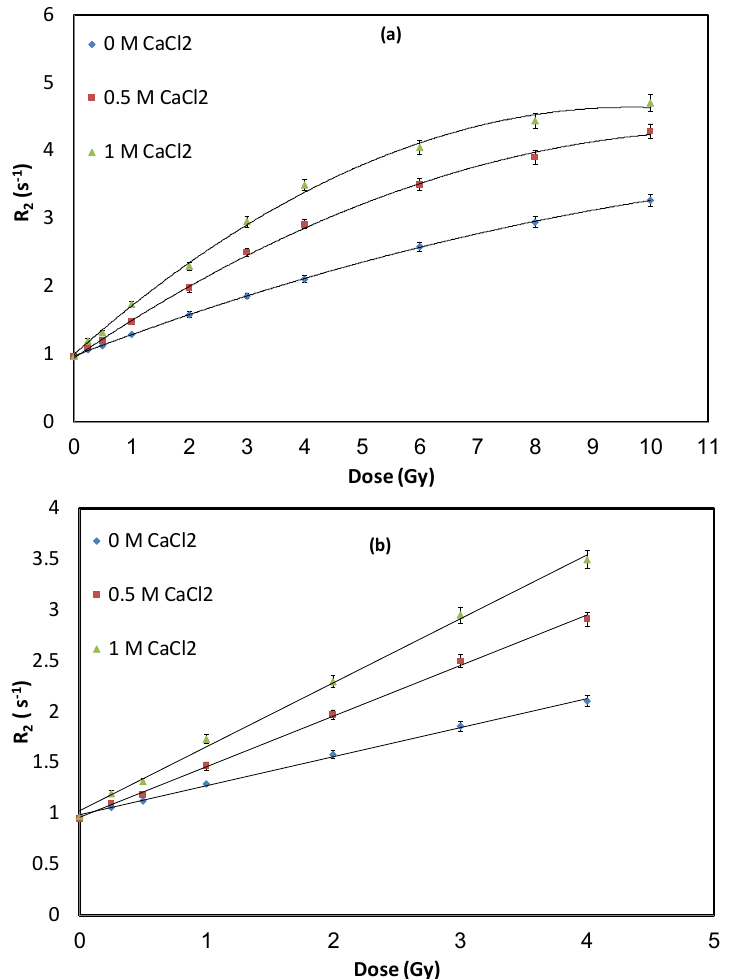
Figure 1. R 2 of gels with various concentrations of CaCl 2 when irradiated at doses up to ( a ) 0–10 Gy, and ( b ) 0 − 4 Gy. Error bars are the 2 σ of R 2 values.